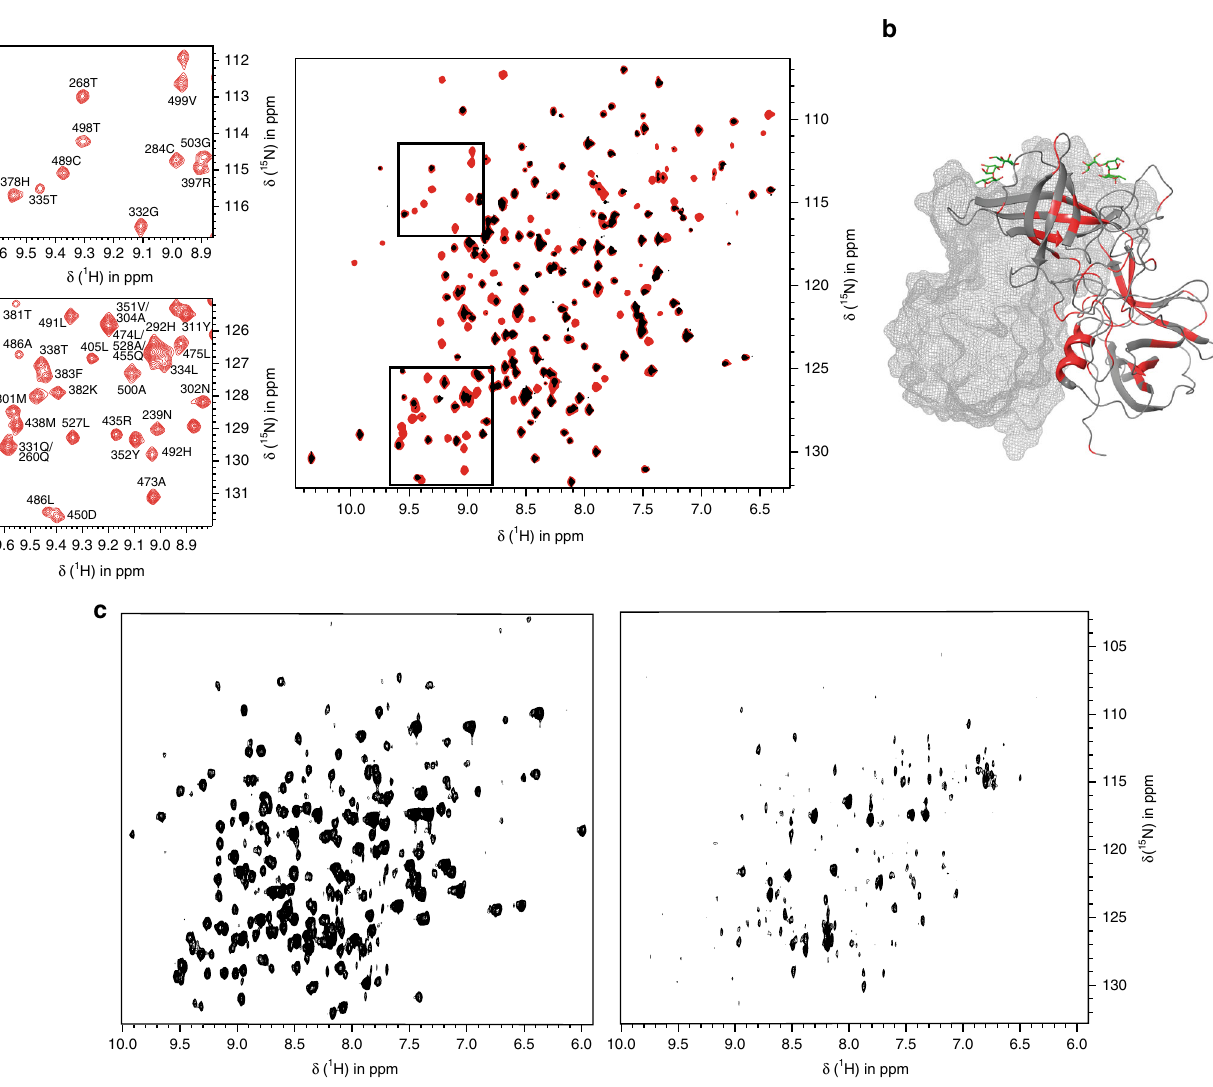
Fig. 1 Exchange of backbone NH protons and protein concentration affect spectral quality. a 1 H, 15 N TROSY HSQC spectra of 100 µ M [ U - 2 H, 15 N] labeled GII.4 Saga P-dimers before (black) and after (red) protein refolding recorded on a Bruker AVIII 500 MHz NMR spectrometer. Samples were prepared in buffer containing 75 mM sodium phosphate, 100 mM NaCl, and 100 µ M DSS- d 6 in 10% D 2 O with the pH* adjusted to 7.30 and with the temperature set at 298 K. b Non-exchangeable NH protons (red color) mapped onto the surface of GII.4 Saga P-dimers (pdb: 4X06). c Positive 1 H- 15 N projection of all planes along the 13 C dimension of 3D TROSY HN(CO)CACB spectra acquired under identical conditions (in sodium phosphate 20 mM, pH* 7.30) for [ U - 2 H, 13 C, 15 N] GII.4 Saga P-dimers at concentrations of 180 µ M (left) and of 300 µ M (right). Source data are provided as a Source Data fi